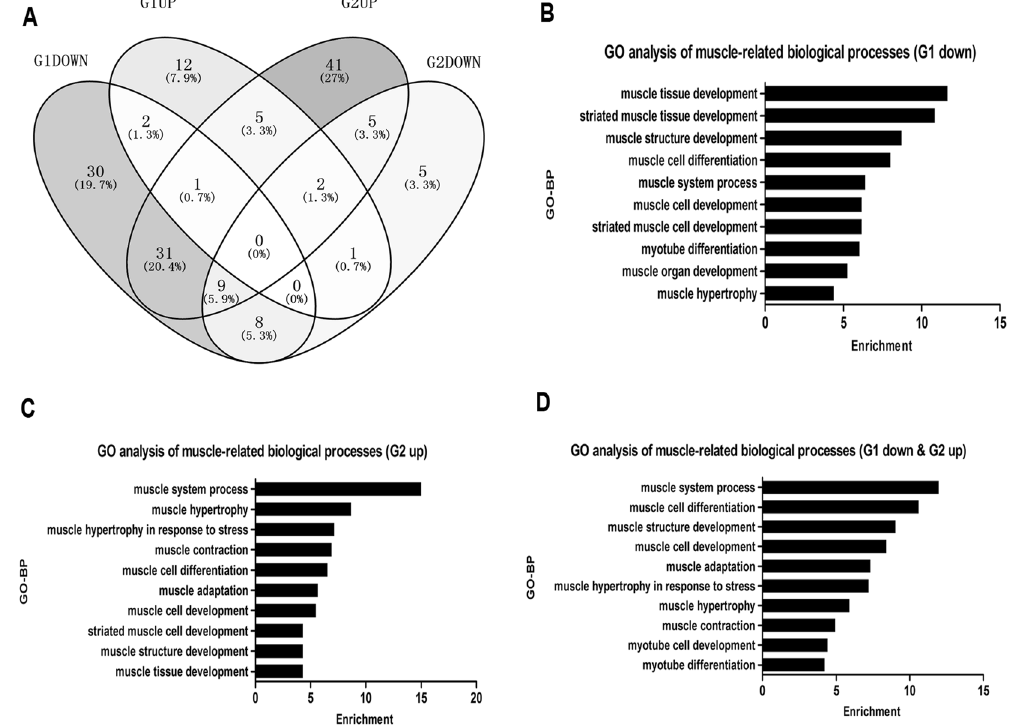
Figure 4. Venn diagram and GO analysis of DE-miRNAs. ( A ) G1 represents embryonic stages, G2 represents postnatal stages, the upper circle represents miRNAs with higher expression in LR, and the lower circle represents miRNAs with lower expression in LR in at least one stage. ( B – D ) Results of GO analysis based on G1 (down) ( B ), G2 (up) ( C ) and their shared miRNAs ( D